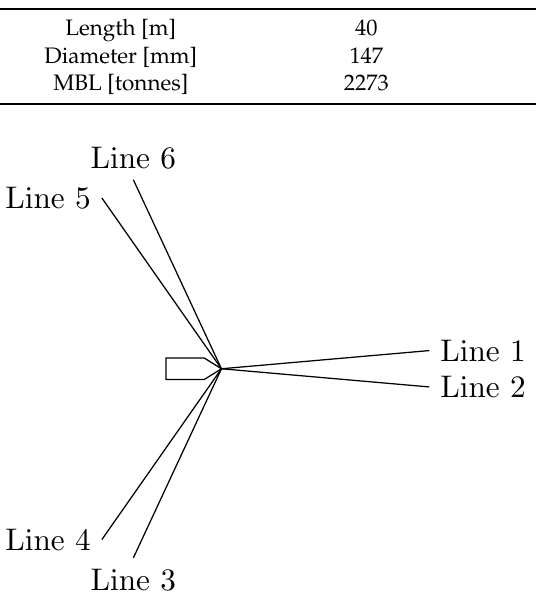
Figure 2. Layout of the mooring